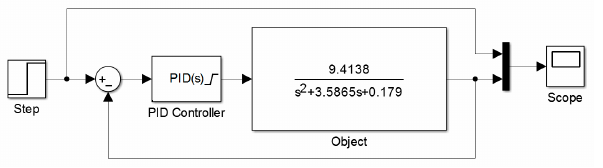
Figure 13. Model of a closed-loop control system of PID controller with auto-tuning.